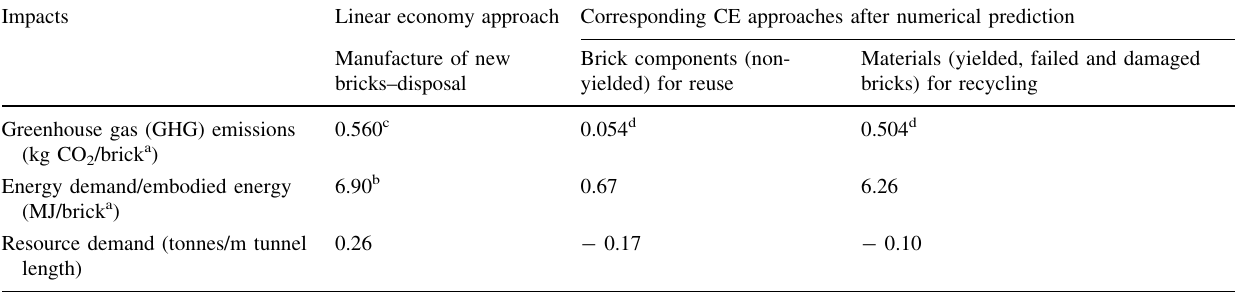
Table 6 Linear versus corresponding circular economy approaches: comparison of environmental and resource indicators for underground infrastructures Impacts Linear economy approach Corresponding CE approaches after numerical